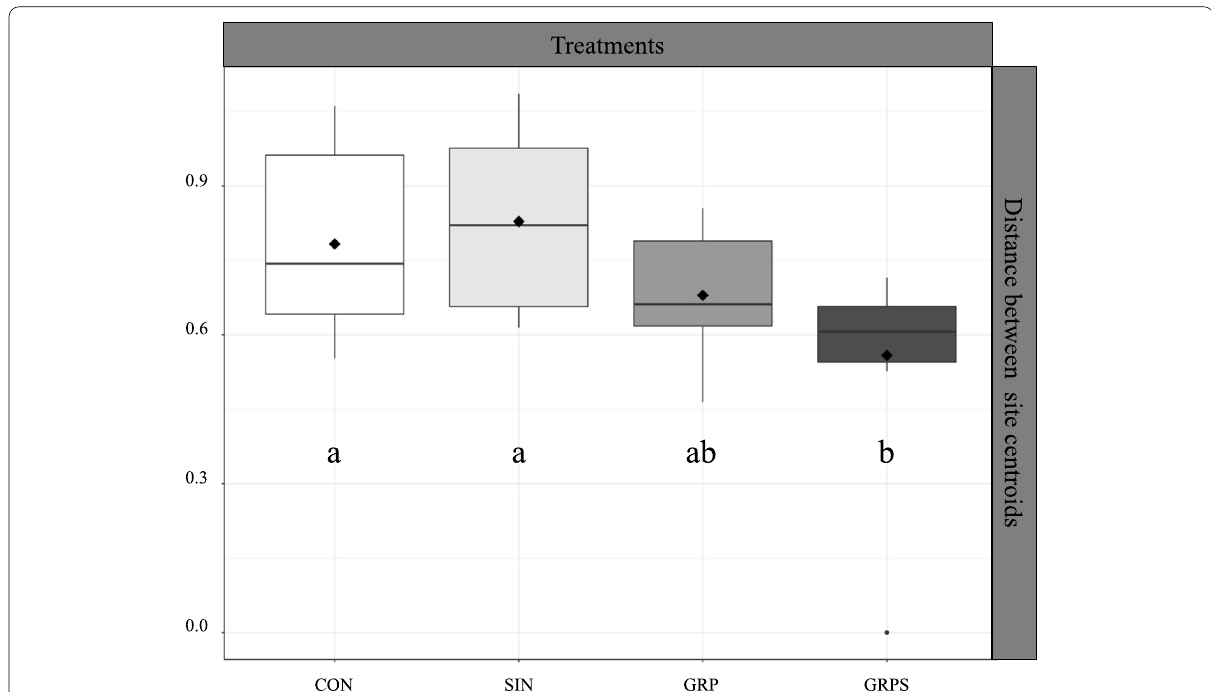
Fig. 4 Multivariate analysis of variance of beta diversity among sites as a function of treatments ( B among_Site ). Beta diversity among sites as a function of treatments ( B among_Site ) are plotted as mean Euclidean distances between centroids for the same treatments. CON: controls; SIN: single-tree selection cut; GRP: group-selection cut; GRPS: group-selection cut with scarification